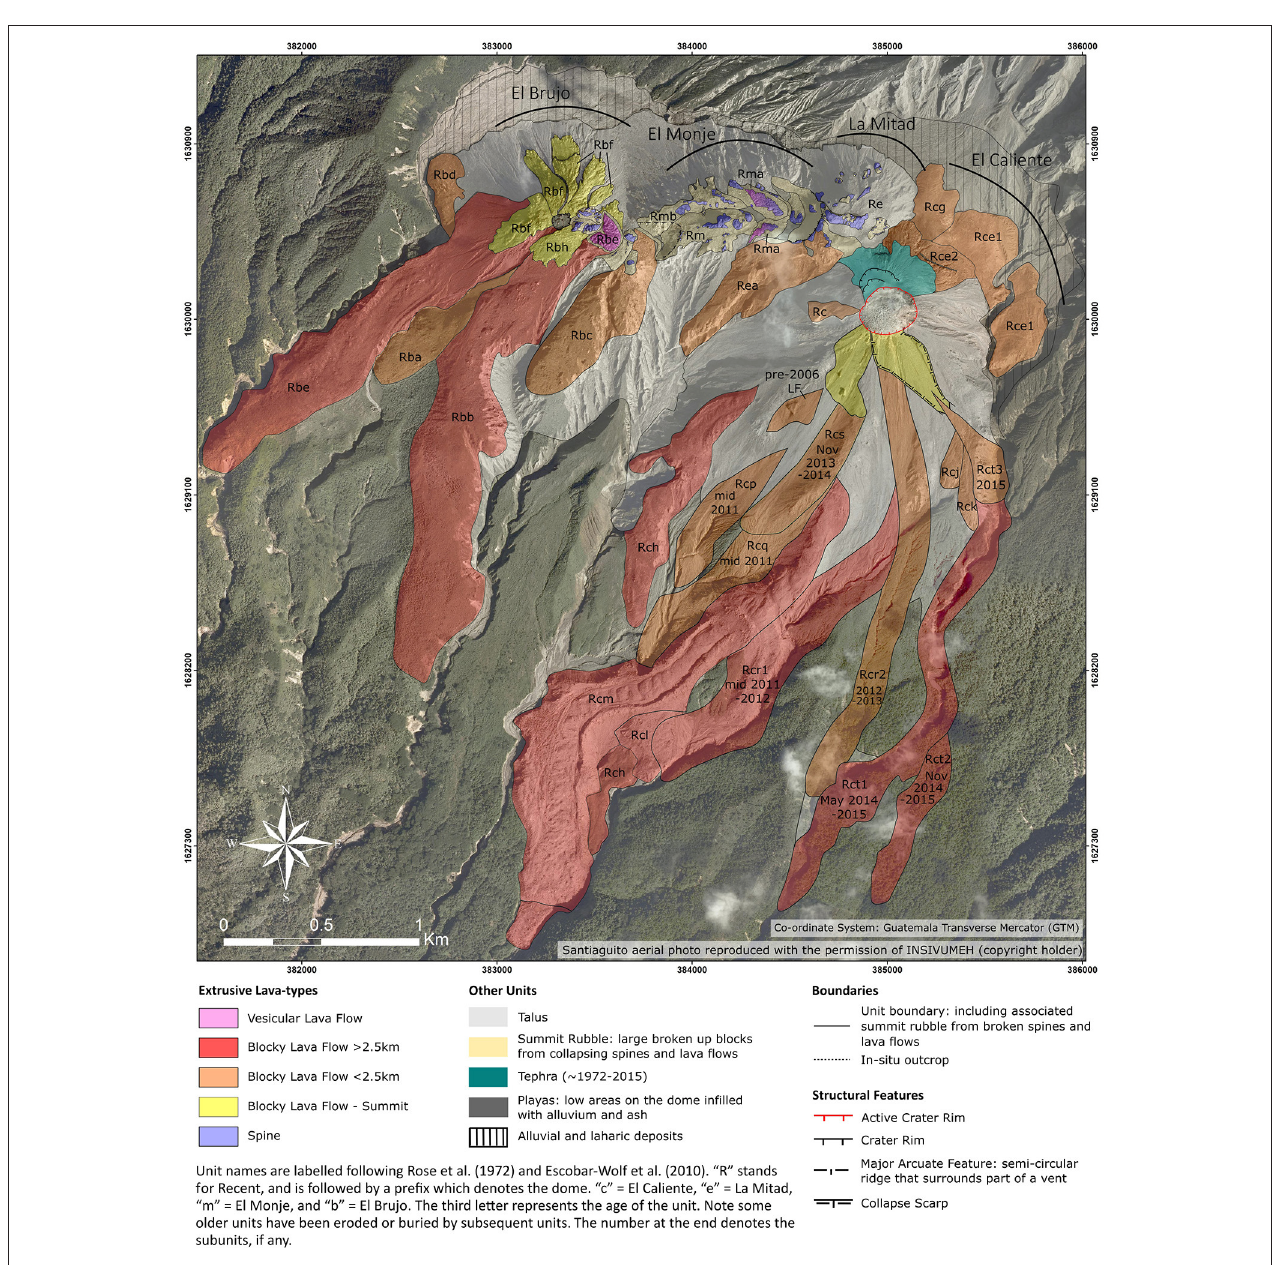
FIGURE 4 | Lava type map of the Santiaguito Lava Dome Complex. This map is developed as a companion map to Escobar-Wolf et al. (2010) and Ball et al. (2013). Pre − 2010 dome and lava flow features were mapped by Escobar-Wolf et al. (2010) and Ball et al. (2013) from aerial 0.5m pixel resolution aerial orthophotos 1860-II-14 and 1860-II-19 (acquired between November 2005 and April 2006 by the Instituto Geográfico Nacional) as well as by direct field mapping. Recent post − 2011 collapses and lava flows were mapped from NASA ASTER images, field observations, INSIVUMEH photos, and Google